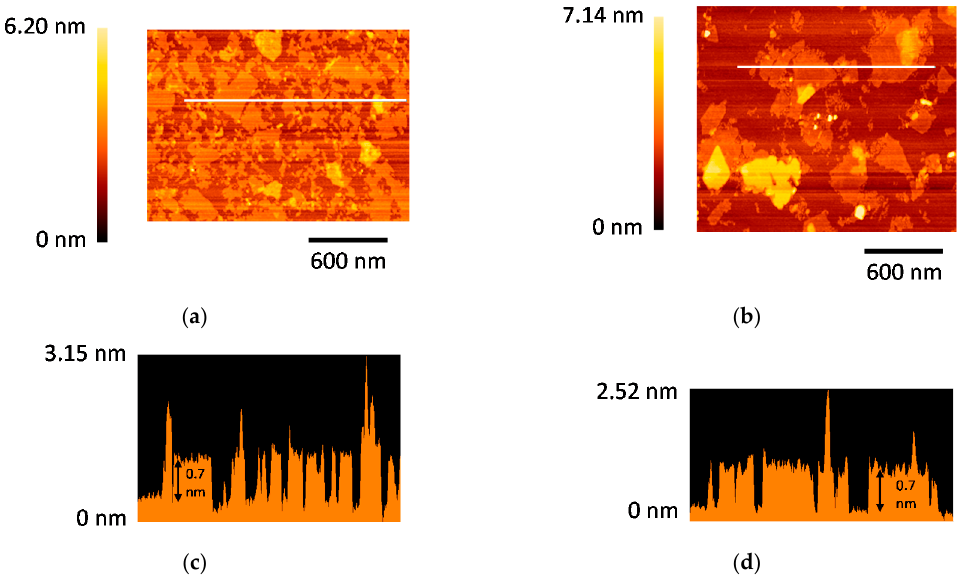
Figure 3. Atomic force microscopy (AFM) images of ( a ) H 0.23 Co 0.23 Mn 0.77 O 2 nanosheets (C23M77NS) and ( b ) MnO 2 nanosheets (M100NS) deposited onto mica substrates. Panels ( c ) and ( d ) show cross-sectional profiles of the regions indicated by the white lines in Panels ( a ) and ( b ), respectively.